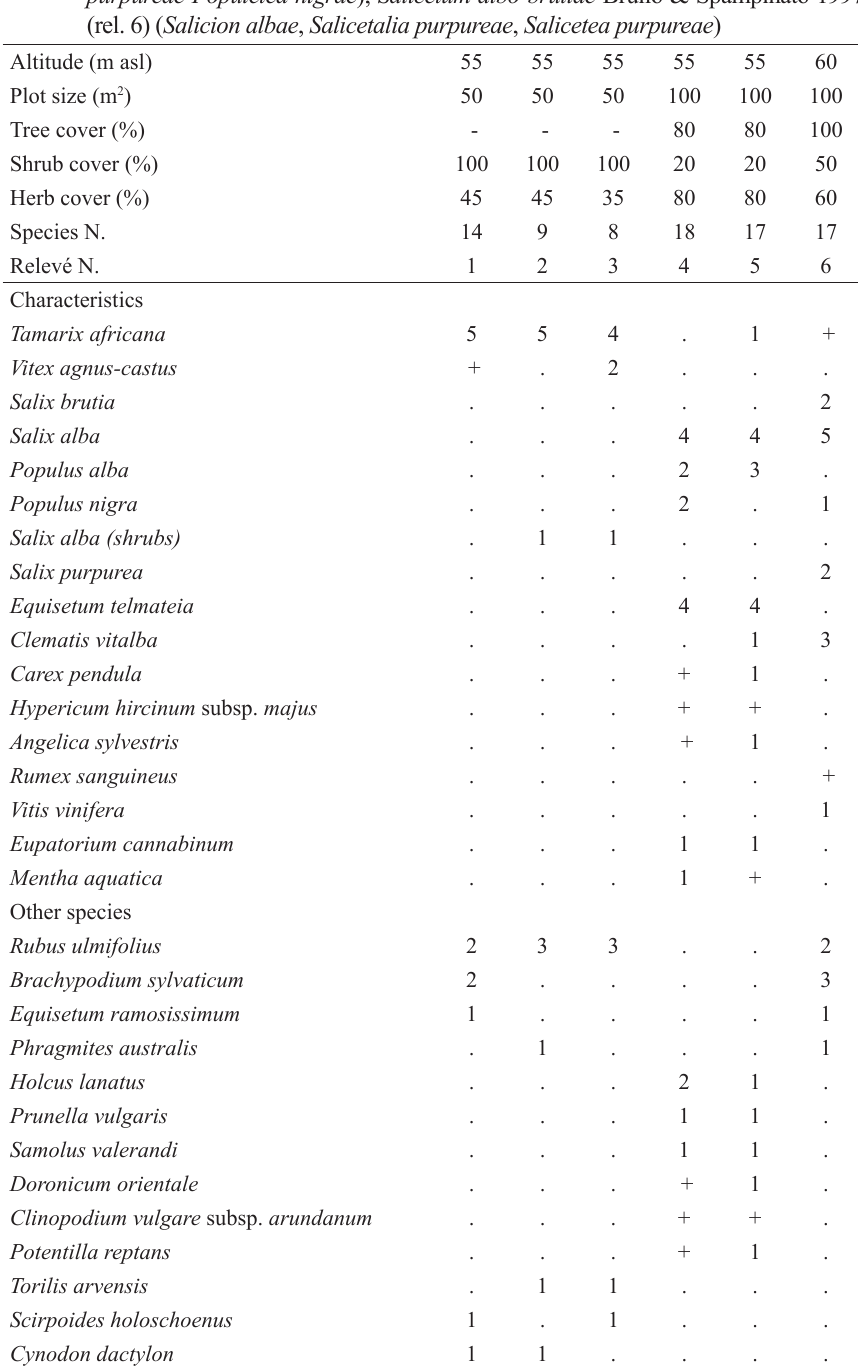
Table 7. Riparian thickets and woods. Tamarix africana comm. (rel. 1-3) ( Tamaricion africanae , Tamaricetalia africanae , Nerio oleandri-Tamaricetea africanae ); Salix alba and Populus alba comm. (rel. 4-5) ( Populion albae , Populetalia albae , Salici purpureae-Populetea nigrae ); Salicetum albo-brutiae Brullo & Spampinato